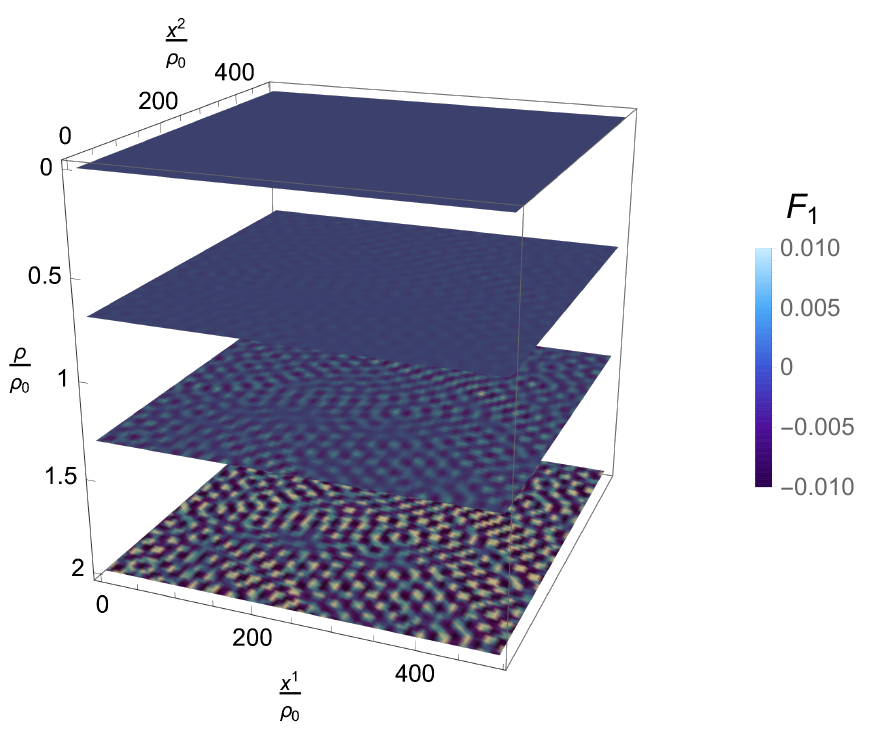
Figure 5 . A stacked density plot of the t , x 1 component of the metric, F 1 ( ρ, t, ~x ) , as a function of the radial coordinate ρ at time t = 1125 ρ 0 , ensemble averaged over 36 runs. As the radial coordinate ρ increases (moves farther from the boundary) the magnitude of the perturbations induced by the driving force become larger. In each run there exists an apparent horizon at ρ = ρ h ( t, ~x ) with 0 . 9 . ρ h . 1 . 1 .